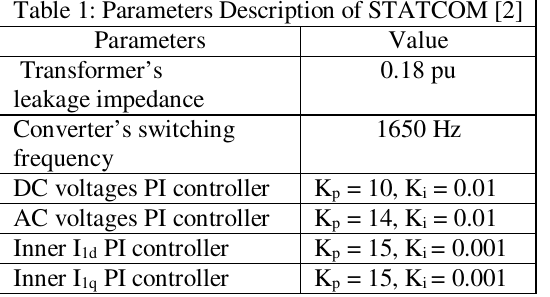
Table 1: Parameters Description of STATCOM [2]